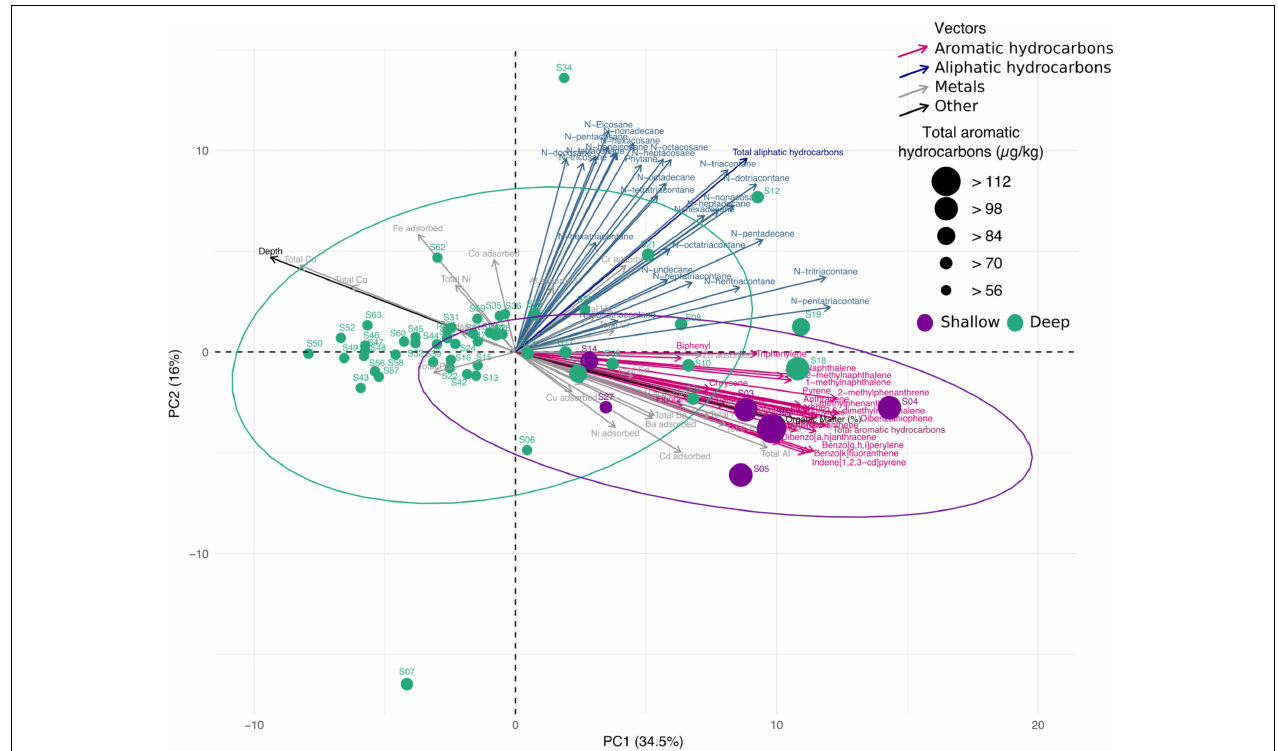
FIGURE 4 | Principal component analysis of abiotic variables measured in sediment samples from the swGoM. Ellipses indicate confidence = 0.9 in groups according to depth. Circle size represents the total aromatic hydrocarbon concentrations. Sample sediments from depths less than 500 m are shown in